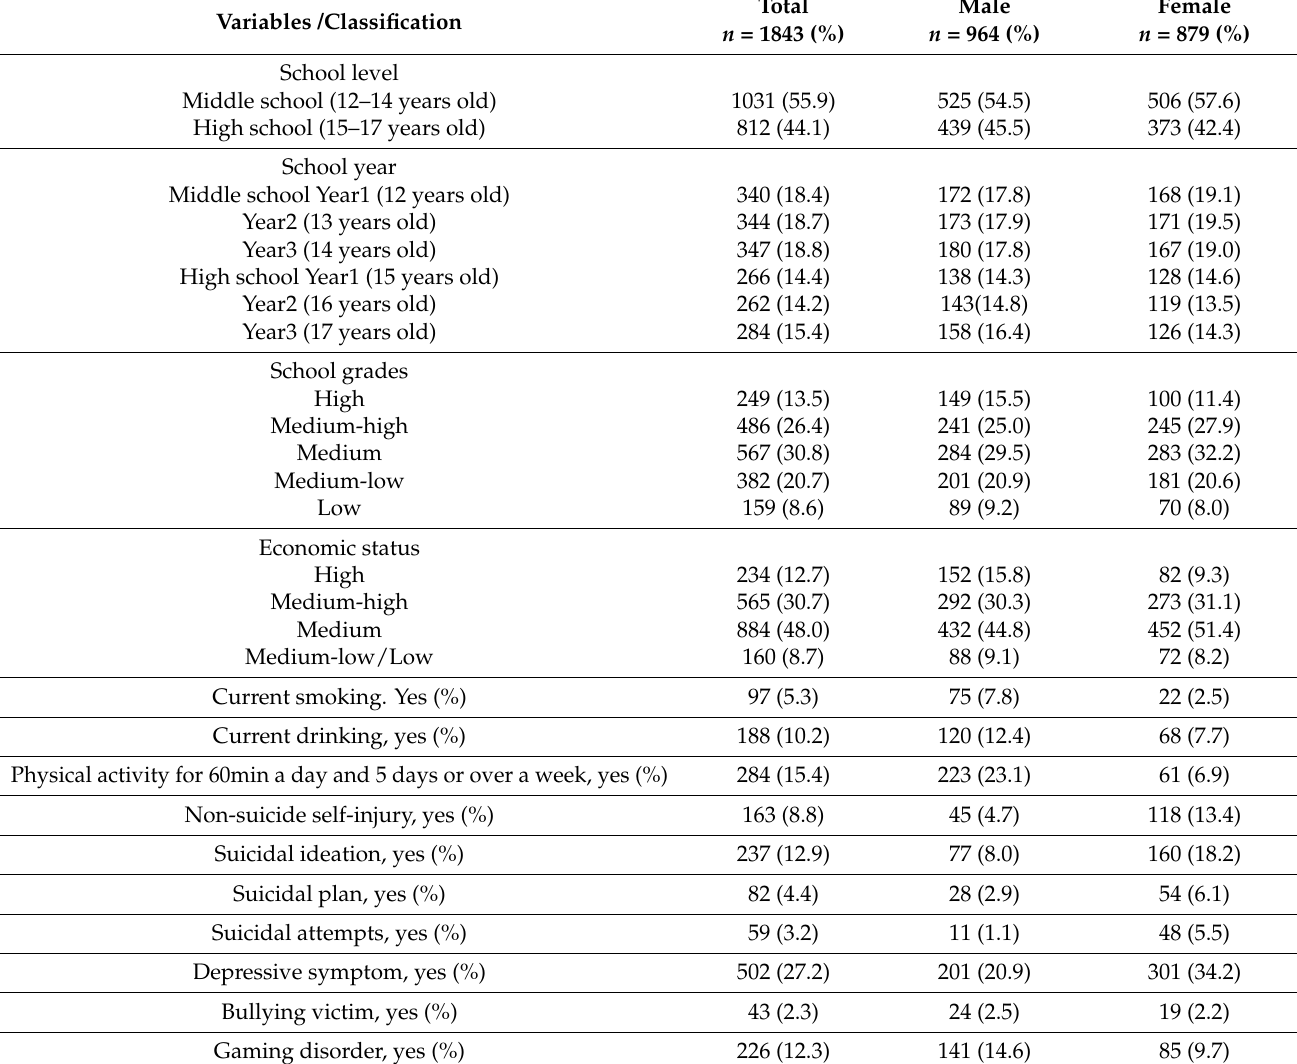
Table 1. General Characteristics of study subjects of prevalence survey for non-suicidal self-injury among adolescents in South Korea,